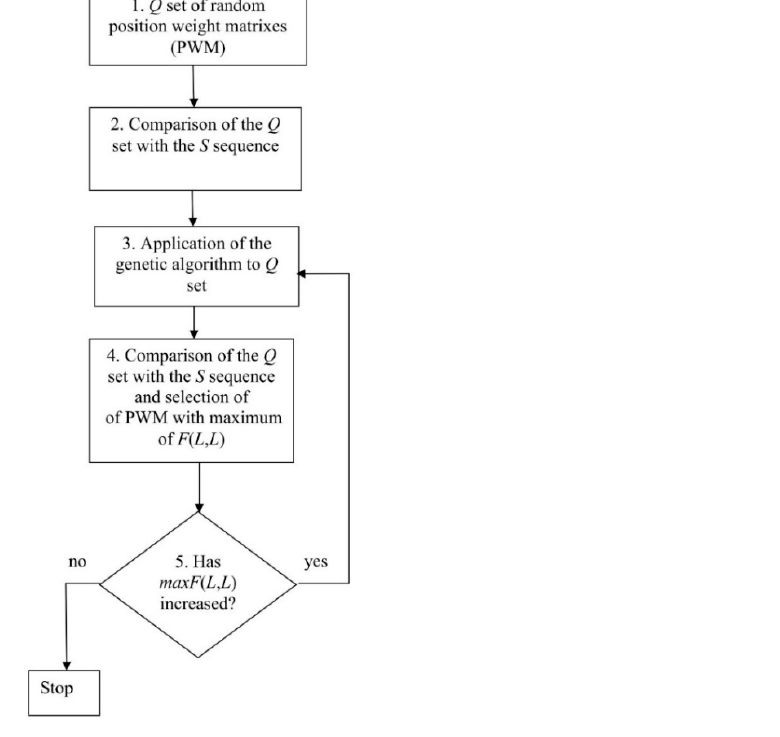
Figure 1. Algorithm for calculating the best position-weight matrix